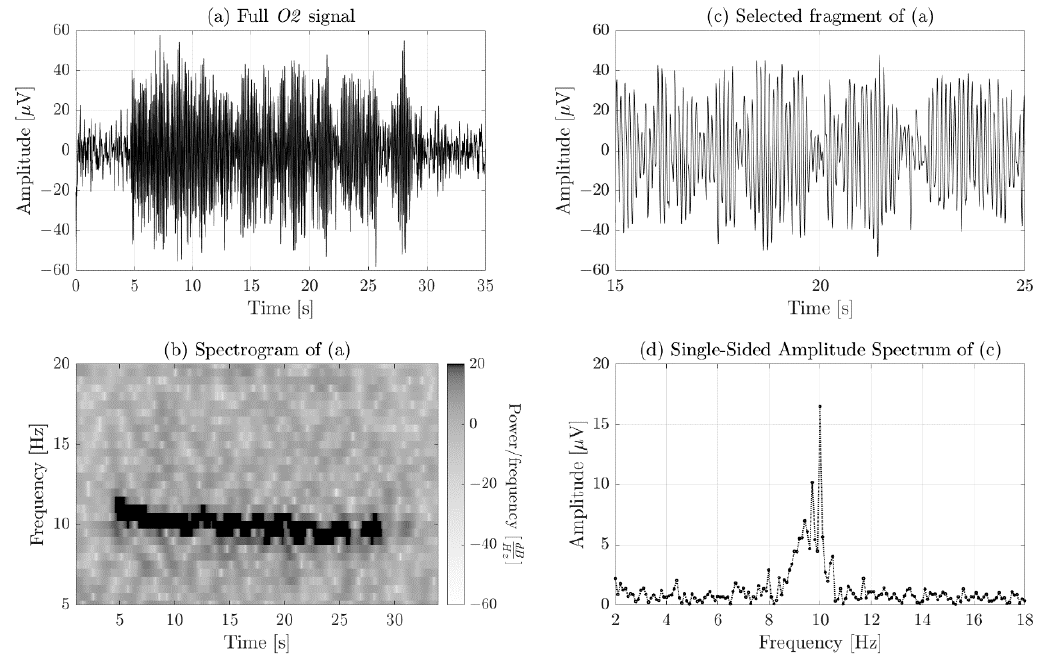
Figure 5. Plots of the measured signal: ( a ) full signal, ( b ) spectrogram of the full signal, ( c ) analyzed fragment with the most apparent alpha-waves, ( d ) the discrete Fourier transform of the ( c ) plot.